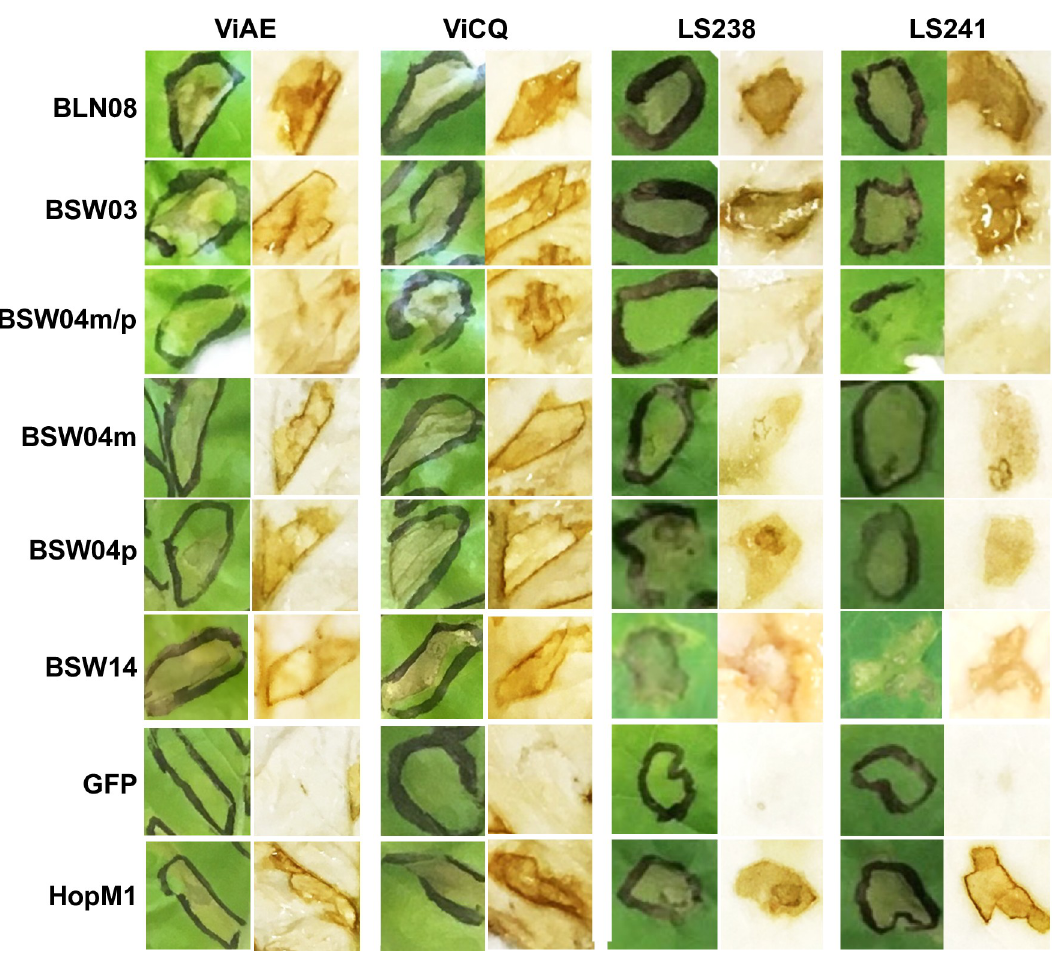
Fig 8. Example agroinfiltration results of reactions of L . sativa ViAE and ViCQ and their respective progenitor R gene donors L . virosa LS241 and LS238 to candidate WY containing effectors from B . lactucae . Photos are representative of a typical leaf. GFP and HopM1 were used as negative and positive controls for necrosis, respectively. Leaves were collected five days post-infiltration and the first column for each accession shows the uncleared leaf tissue; the second column shows leaf tissue cleared in ethanol to make necrosis (brown areas) more visible.